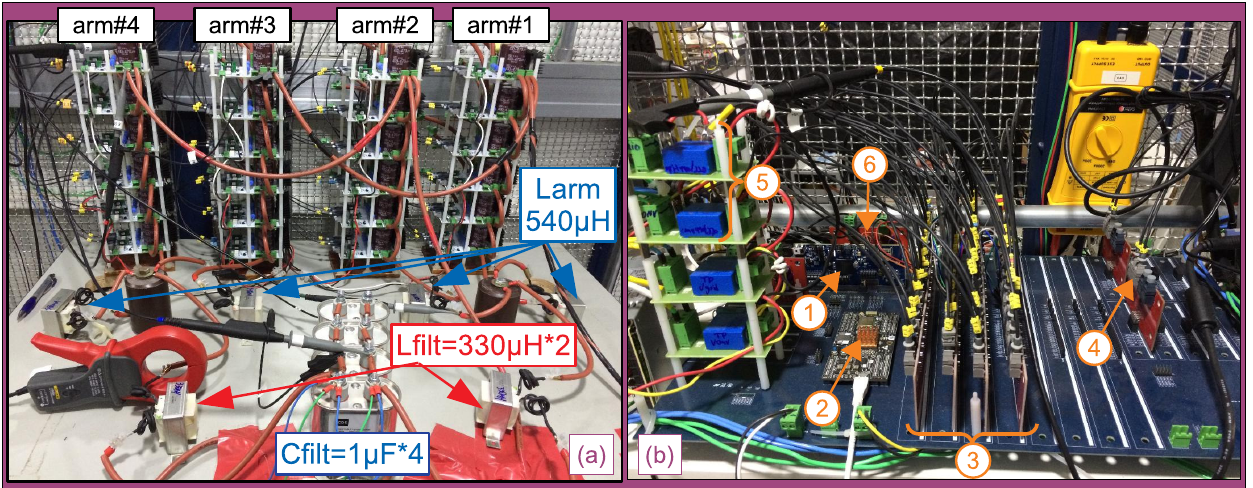
Figure 10. Test bench of the DC–AC converter: ( a ) power stage of the Modular Multilevel Converter (MMC) topology (bi-phase, 4 arms, N = 6 SMs/arm); ( b ) control stage (gate signals sent to the power stage through optical